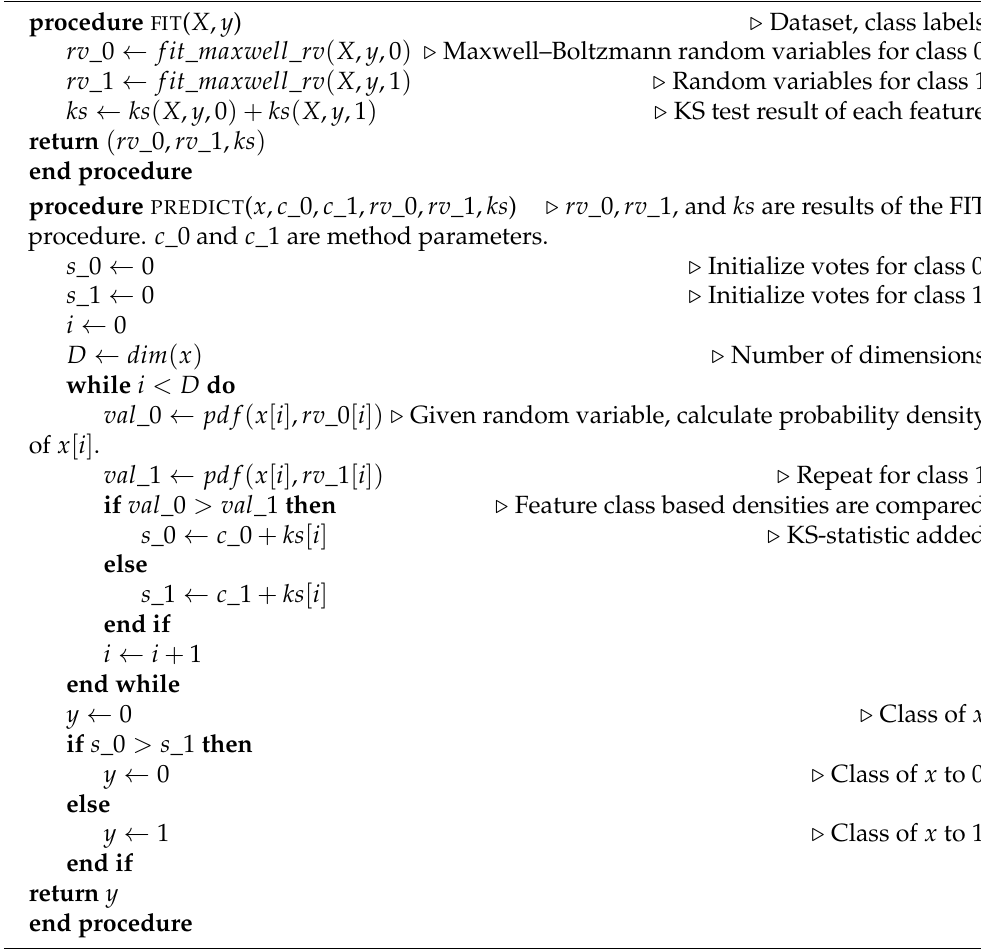
Algorithm 2 Proposed Base Estimator Method II: Maxwell–Boltzmann Distribution based Majority Voting